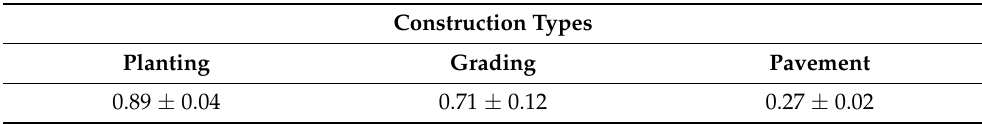
Table 7. Carbon emissions per square meter of planting, grading, and pavement area for construction in the study parks (kg/m 2 ).